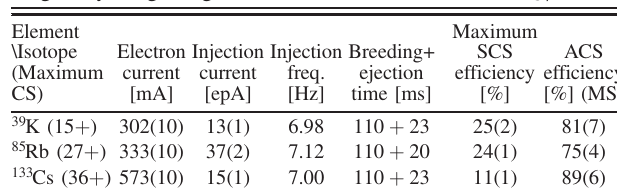
TABLE II. Maximum single charge state (SCS) and all-charge- state (ACS) efficiencies of stable-isotope beams. The ACS efficiencies were measured at the mass slit (MS) after the separator magnet byintegrating theSCSefficienciesobtained ina Q=A